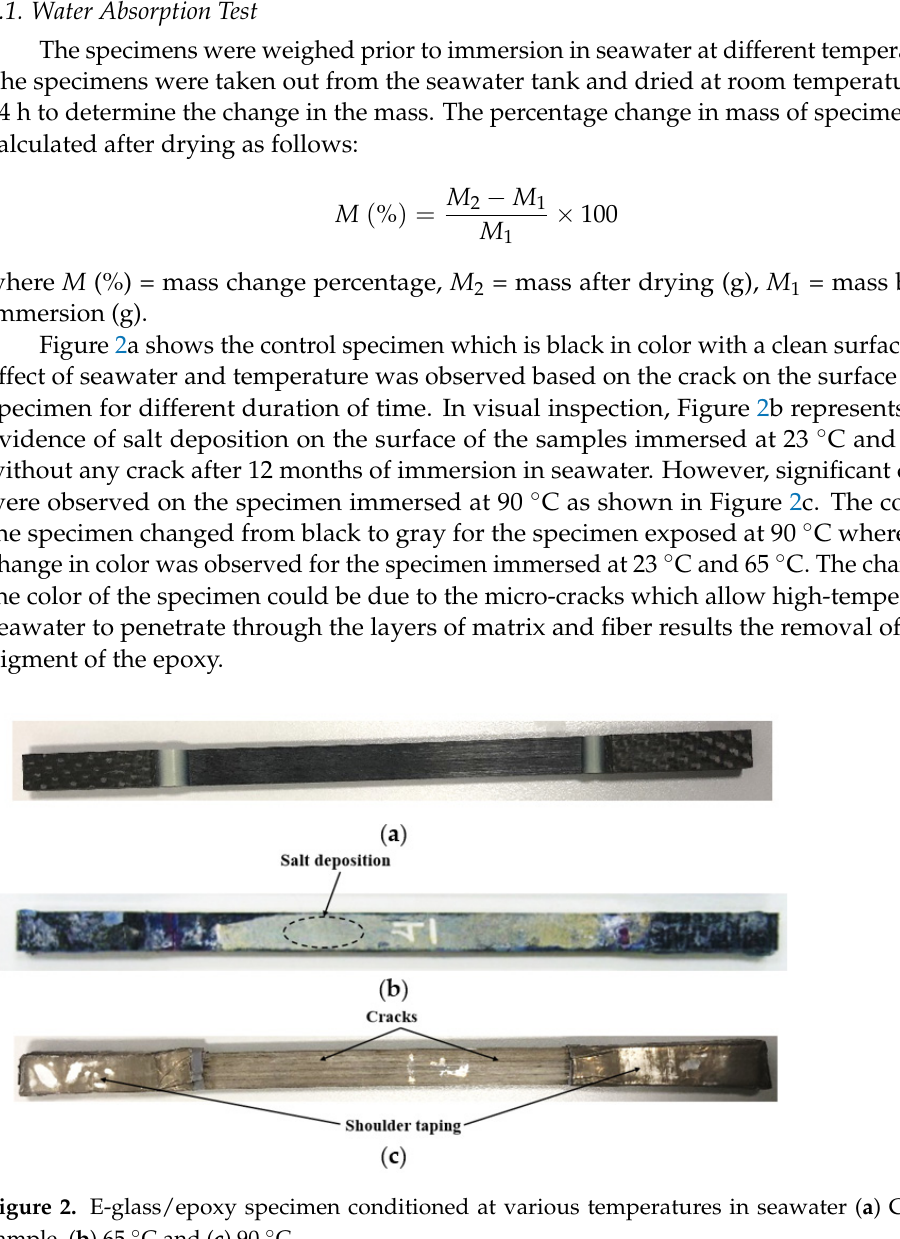
Table 2. Percentage change in mass of E-glass/epoxy specimens.